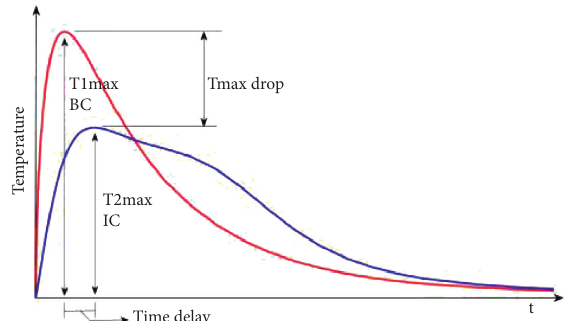
Figure 24: Typical temperature duration curve of the center point of concrete block.